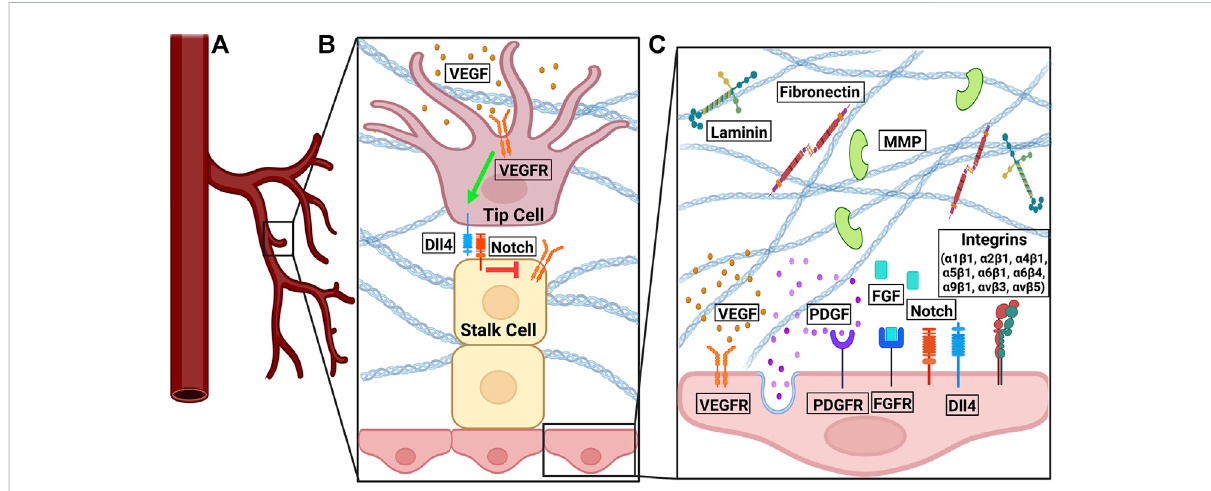
FIGURE 1 The signaling pathways involved in angiogenesis. (A) At the front of a sprouting vessel, (B) VEGF binds to VEGFR on tip cells. VEGFR activation induced the expression of Dll4. Dll4 on the tip cells binds to Notch on stalk cells. Notch signaling in stalk cells downregulates the expression of VEGFR2/3 instalk cells. (C) VEGF-VEGFRand FGF-FGFR signaling promote pro-angiogenic signals, cell proliferation, and cell survival. PDGF-PDGFR binding leads to vessel sprouting and stabilization. Notch interacts with Dll4 in a feedback loop to regulate cell migration and proliferation. Fibronectin and laminin bind to integrins to promote endothelial cell proliferation, survival, migration, and tube formation. Various integrin isoforms promote angiogenesis through different overlapping pathways. MMPs degrade denatured collagen in the basement